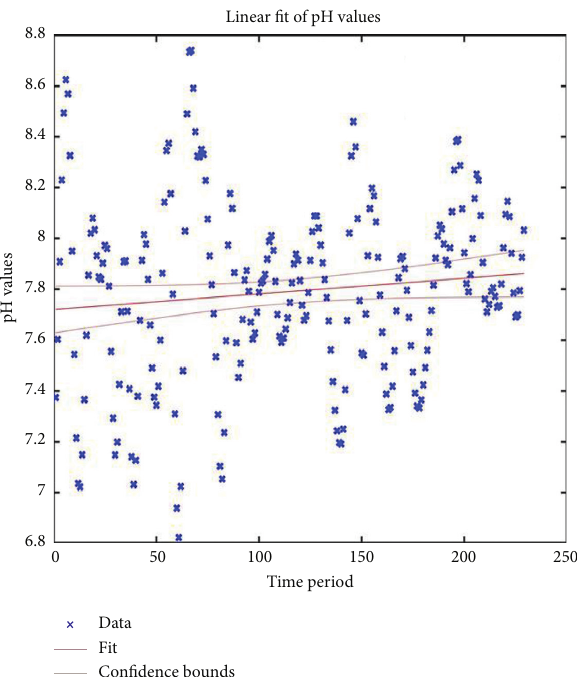
Figure 6: Linear regression fit of pH values at